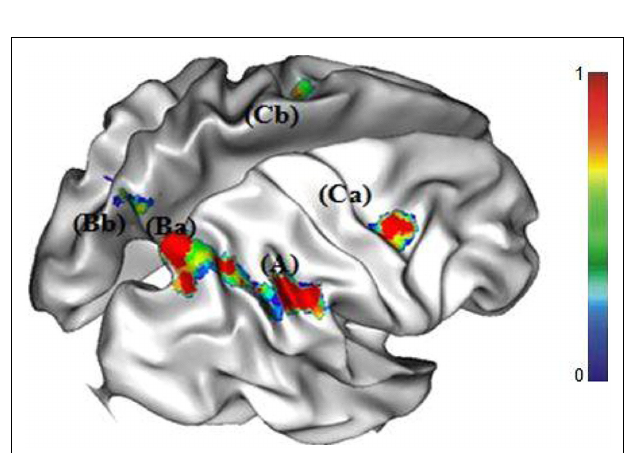
FIGURE 2 | Neural correlates of strategy selection (A) right precuneus, (B) right angular gyrus, (Ca) right and (Cb) left supramarginal gryi, (Da) right and (Db) left middle frontal gyri, (E) right dorso-lateral prefrontal cortex (DLPFC), and (F) right anterior cingulated cortex.